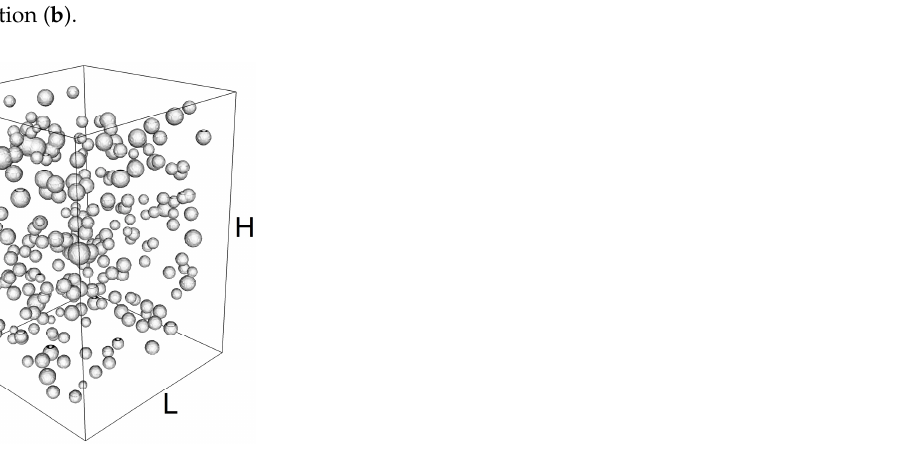
Figure A3. Representative volume element (RVE) of sandy-cement sample. Height of RVE H ≈ 715 µm , H:W = 2.1:1.5.